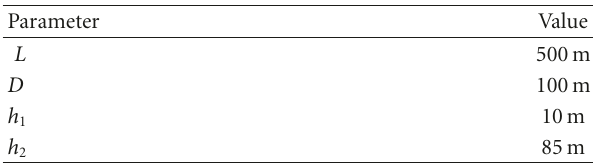
Table 1: Channel geometry.